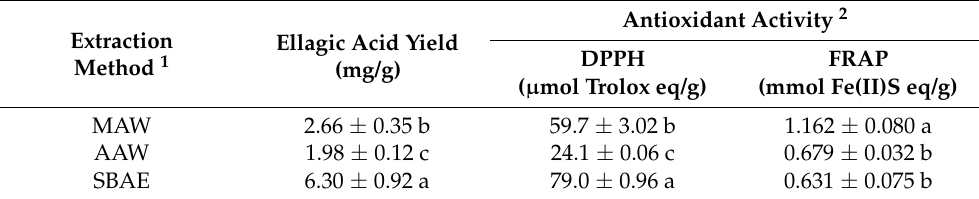
Table 2. Ellagic acid yield and antioxidant activity of extracts derived from organic solvent method and sodium bicarbonate assisted